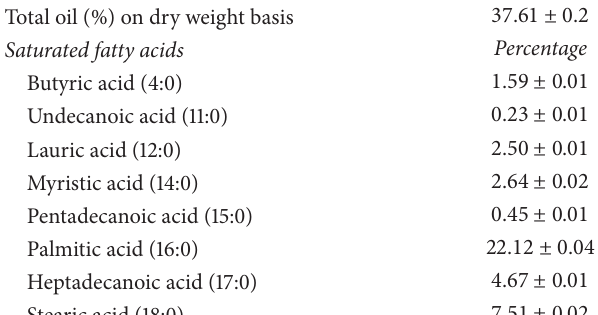
Table 1: Percentage of oil and fatty acids composition of Heynea trijuga seed kernel